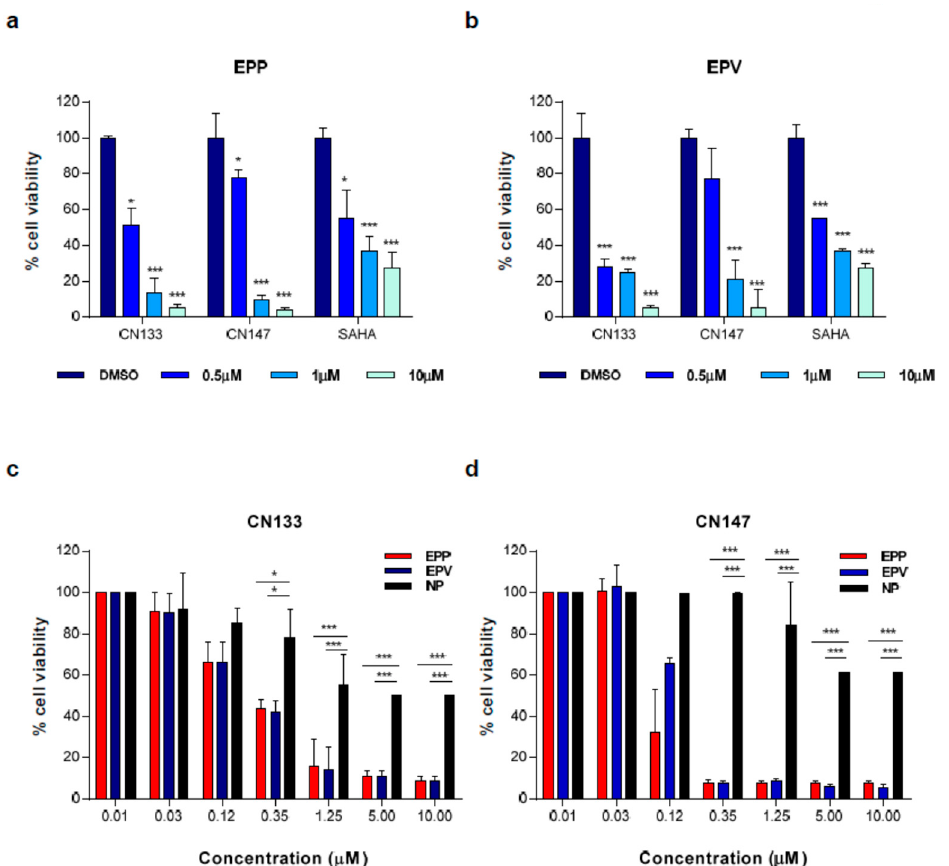
Figure 2. CN133 and CN147 have stronger anti-tumoral activity than SAHA and are more cytotoxic in tumor cells than in non-transformed cells. Cell viability assay in EPP ( a ) or EPV ( b ) cell lines with either vehicle (DMSO) or with the indicated HDACi at 500 nM, 1 µ M or 10 µ M for 72 h. Cell viability was evaluated using Alamar Blue reagent. Graph represents the average of three independent experiments. ( c , d ) Cell viability assays in EPP, EPV or neuronal progenitors (NP) treated with vehicle (DMSO) or the indicated doses of CN133 ( c ) or CN147 ( d ) for 72 h. Cell viability was evaluated using Alamar Blue reagent. Each graph represents the average of three independent experiments ( n = 6 / each experiment) ± SEM. * p < 0.05; ** p < 0.01; *** p < 0.001.